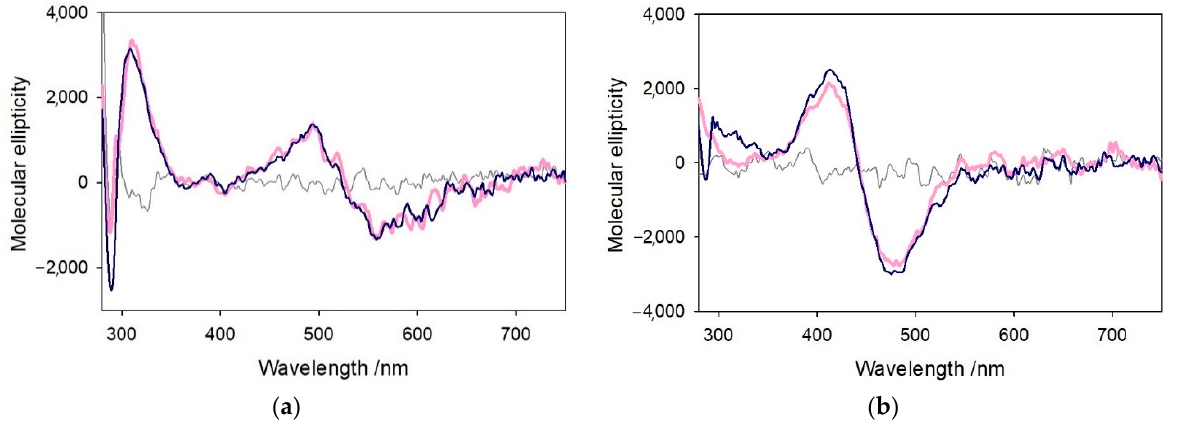
Figure 10. ( a ) Vis-CD spectra of of copper(II) (2 mM) alone in 5 mM phosphate buffer solution at pH 7.4 (grey trace) and upon the addition of 1 equiv. A β 4–16 peptide (2 mM, pink) and further addition of 1 equiv. of Ni II to the initial complex (blue). ( b ) Vis-CD spectra of nickel(II) (2 mM) alone (grey trace) and upon the addition of 1 equiv. A β 4–16 peptide (2 mM, pink) and further addition of 1 equiv. of Cu II (blue).